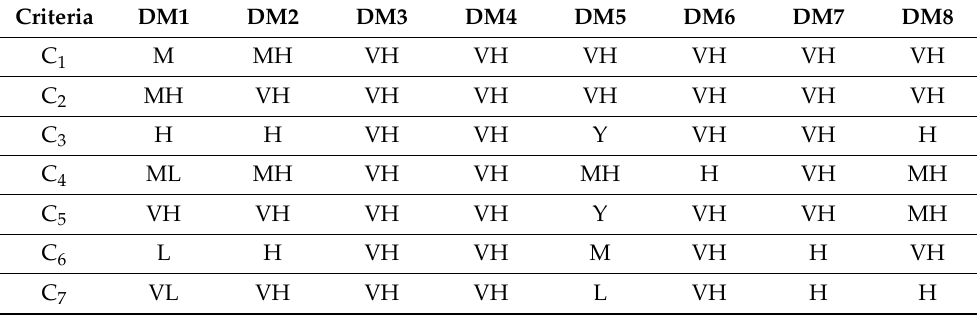
Table 4. Assessment of decision criteria by decision makers. Criteria